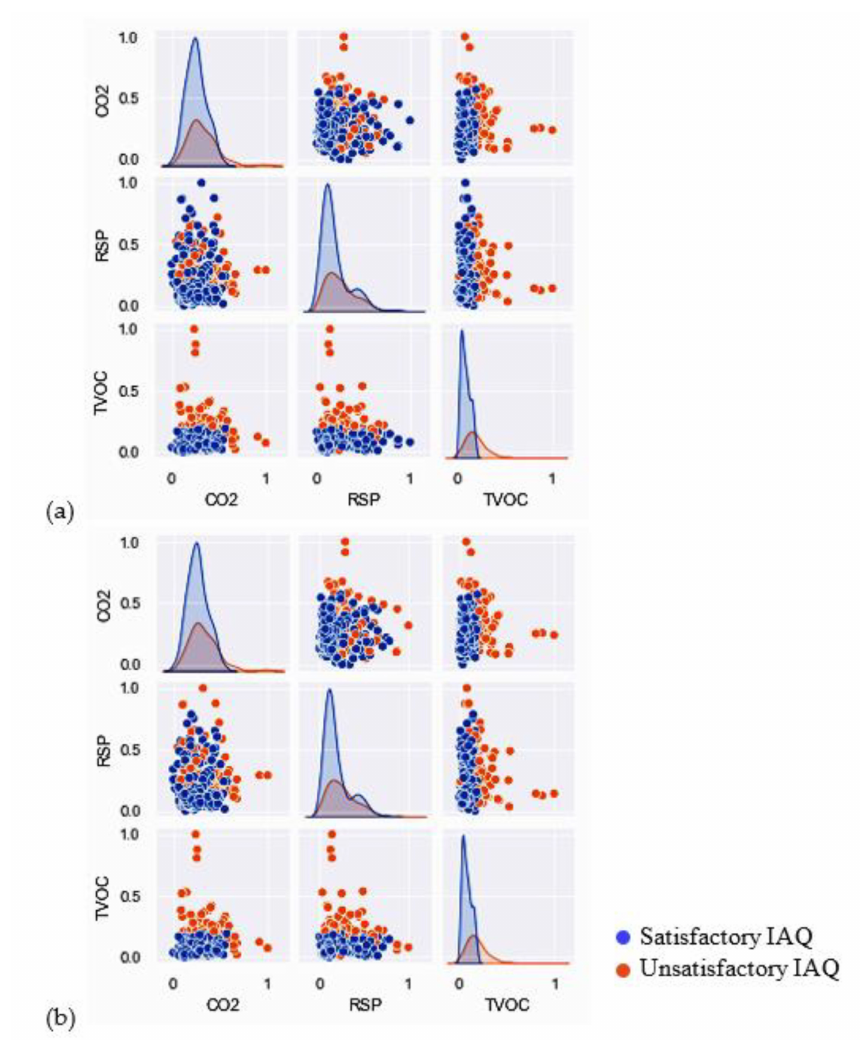
Figure 1. Pair plots of CO 2 , RSP, and TVOC grouped by assessed indoor air quality (IAQ) against assessment ( a ) Scheme 1 ( b ) Scheme